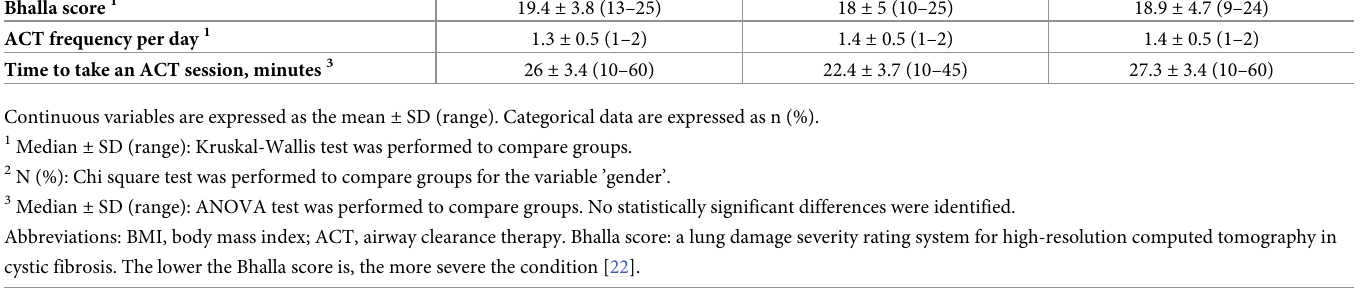
leaving a total of 15 patients in the TG, 15 patients in the CG, and 13 patients in the PG (Fig 1). The percentage of participants who withdrew from the study (20.4%) was lower than the potential withdrawal estimated for the study (27.8%, 15 participants). The groups had similar withdrawal distribution. The demographic and clinical data and ACT variables are shown in Table 2; the data reflect standard characteristics of the population of children with CF and show no statistically signifi- cant differences between groups in the baseline measures. Concerning the baseline use of adjuncts to ACT prior to the intervention, the most com- mon adjuncts to ACT were the use of television or other audiovisual devices by 28 (66.7%) par- ticipants, while music was used by 10 (23.8%) participants. There were no statistically significant differences in the ACT baseline adjunct measures between the 3 groups. During the intervention, audiovisual devices were frequently used as adjuncts to ACT in the CG (12, 80%), while 12 (80%) and 11 (73.3%) patients in the TG used the music CD frequently after 6